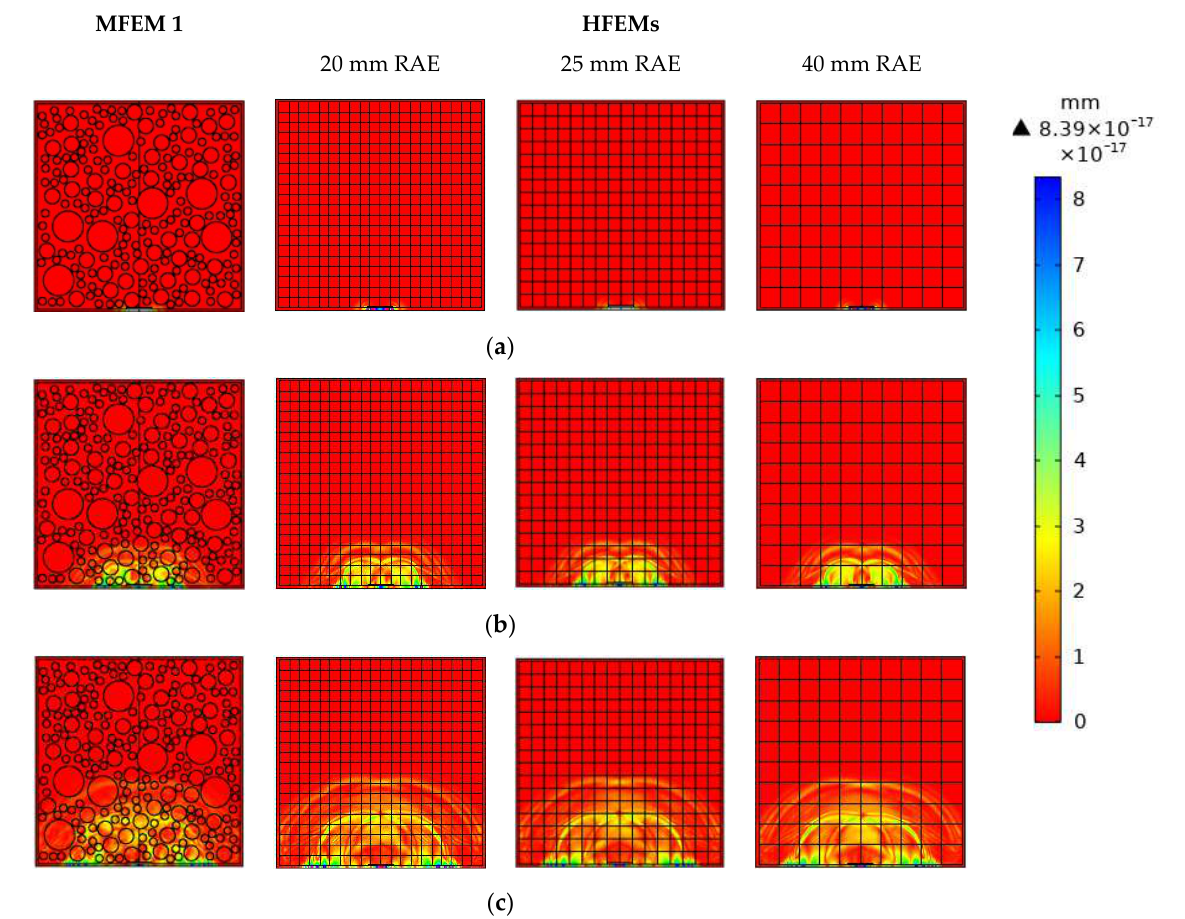
Figure 5. The stress wave fields of both the multi-scale CFST model with a debond defect and its equivalent HFEMs with different RAE dimensions at different time instants: ( a ) t = 1 × 10 −5 s; ( b ) 3 × 10 −5 s; ( c ) t = 5 × 10 −5 s .